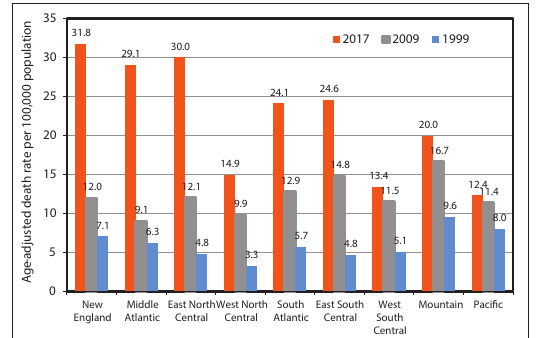
Figure 8: Trends in Drug Overdose Mortality in 9 Census Regions, United States, 1999-2017 Source: Data derived the National Vital Statistics System, Nation - al Mortality